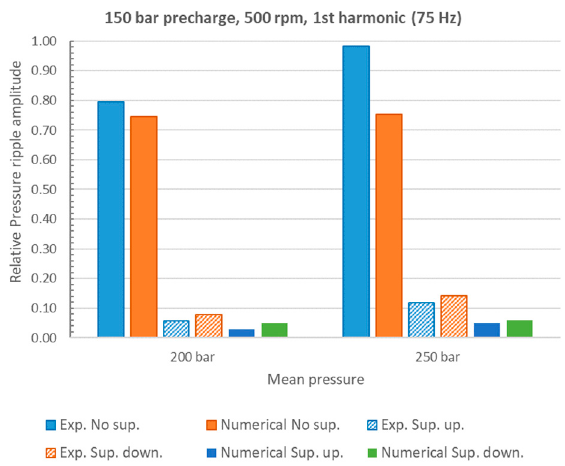
Figure 7. FFT of the pressure ripple, 1st harmonic, pump speed = 500 rpm.